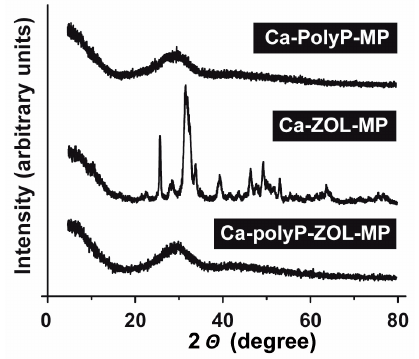
Figure 3. XRD pattern obtained from ( above ) “Ca-polyP-MP”, ( middle ) “Ca-ZOL-MP”, and ( below ) “Ca-polyP-ZOL-MP”. The characteristic signals in the diffractogram from “Ca-ZOL-MP”, which match those of ZOL, are striking. XRD, X-ray diffraction .